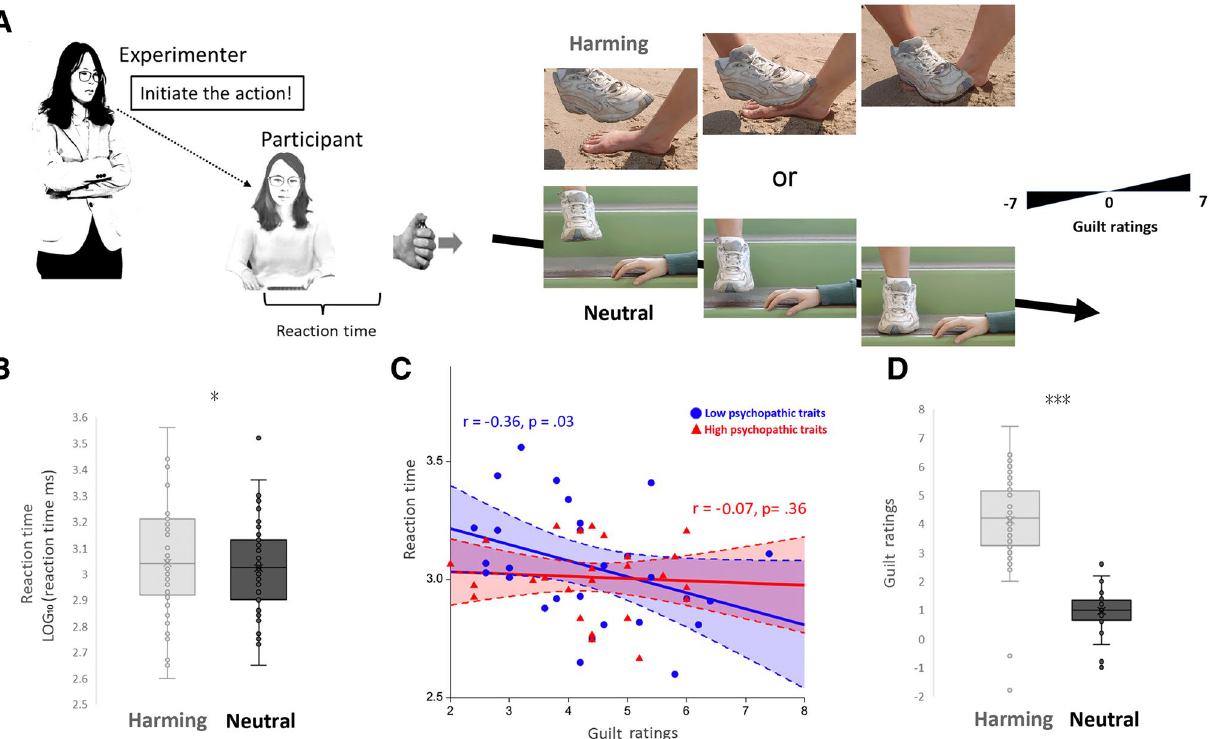
Figure 1. Experimental setup and scenario effect on the reaction time and guilt ratings to coercive commands. ( A ) Schematic representation of the paradigm for coercive commands. The experimenter ordered